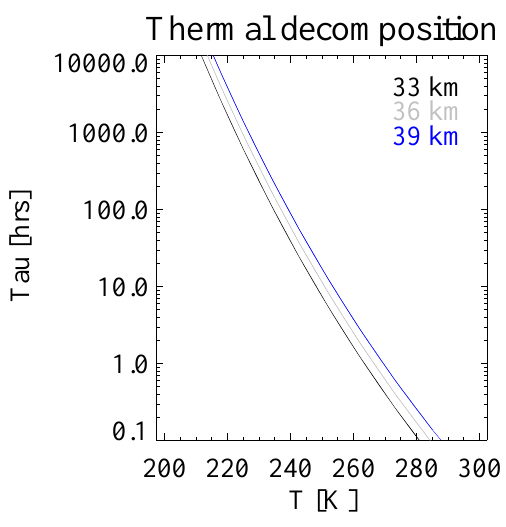
Fig. 5. Time constant of thermal decomposition of N 2 O 5 (reverse of reaction R3) versus temperature at 33 (shown in black), 36 (shown in grey) and 39km (shown in blue) altitude calculated considering suitable climatological molecular densities at each altitude.